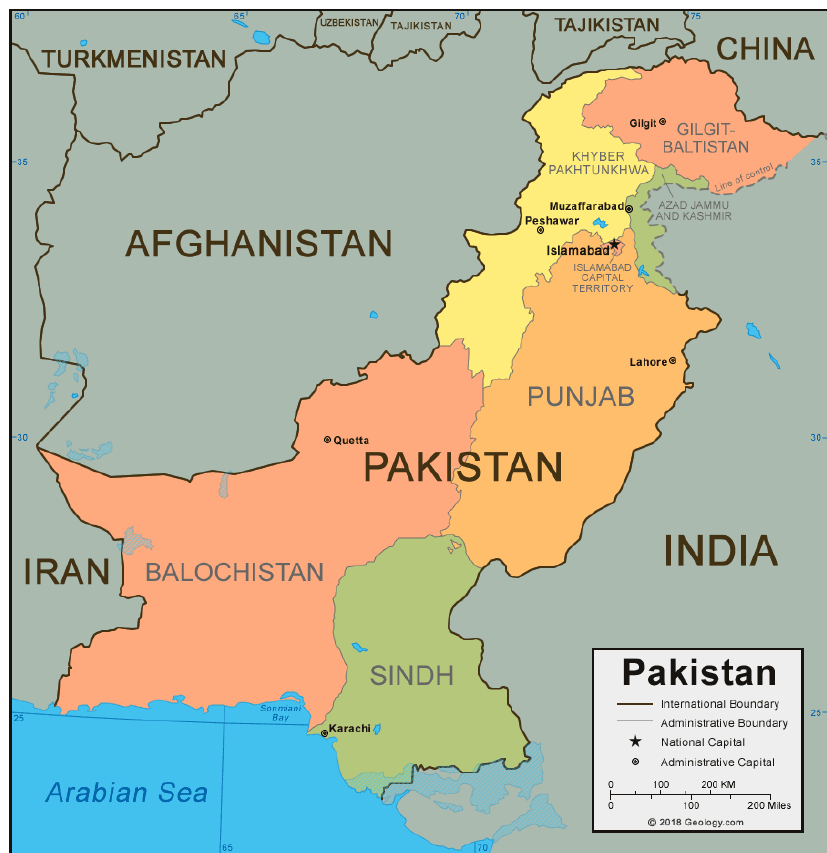
Figure 4. General Map Location of